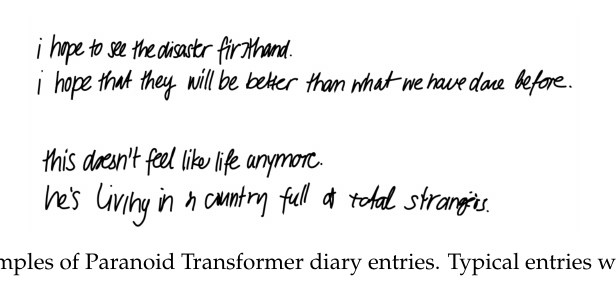
Figure 3. Some examples of Paranoid Transformer diary entries. Typical entries with destructive and ostracized